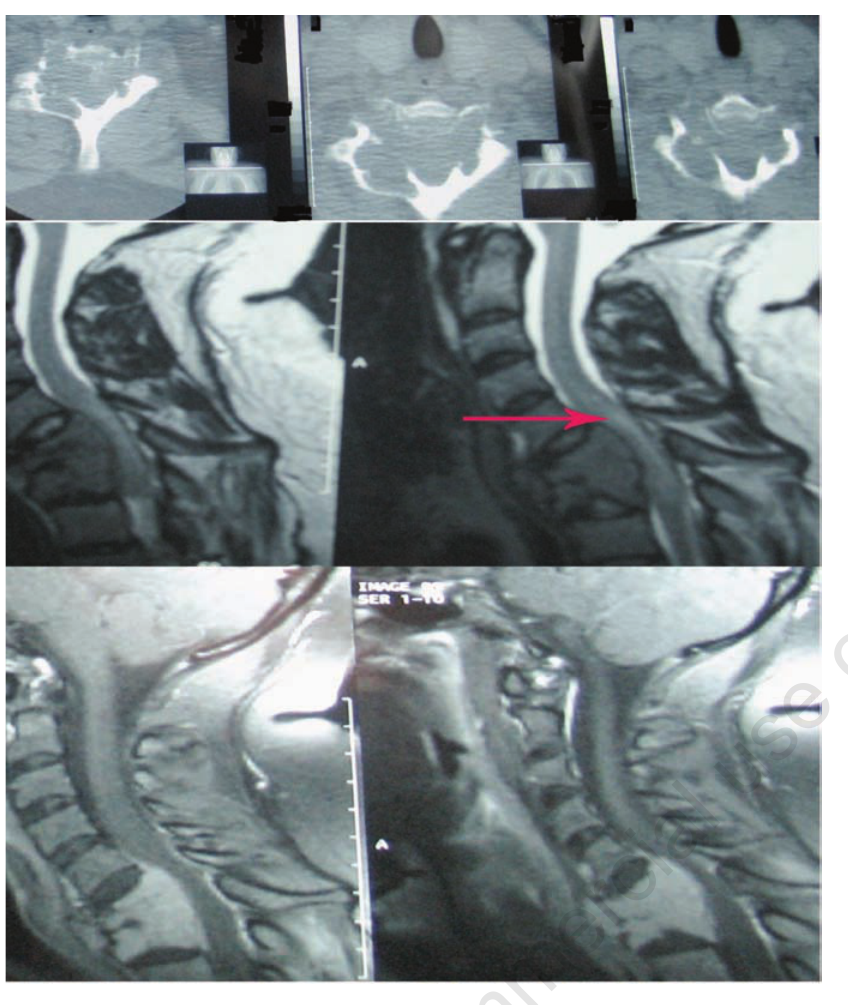
Figure 1. Computer tomography scans showing axial slices of the cervical spine at C6 level (upper three illustrations). T2WI and T1WI post-contrast sagittal magnetic resonance images (lower four illustrations) reveal a C6, C7 vertebral body destructive lesion with kyphotic angulation of the lower cervical spine and retropulsion of the posterior elements of the vertebral body, causing a significant spinal cord compression and buckling (red arrow). The lesion extends into the nerve root exit foramina and to the prevertebral space. A spinal cord high signal is also noted.